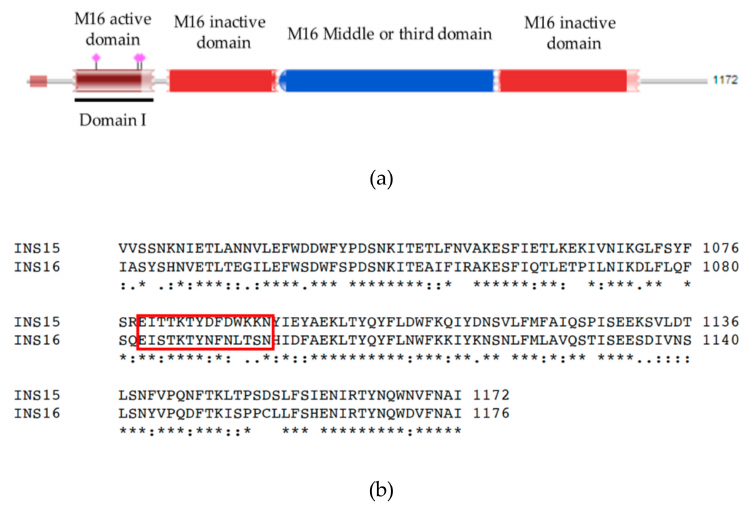
Figure 1. Sequence features of INS-15. ( a ) Diagram of INS-15 of Cryptosporidium parvum illustrating the presence of one M16 active domain, two inactive domains, and one middle or third domain. The black line identifies the domain I. ( b ) Alignment of partial amino acid sequences of INS-15 and INS-16 from C. parvum . The red box shows the di ff erences in amino acid sequences between NS-15 and INS-16 in the area of INS-15-specific polypeptide used in the study. Microorganisms 2019 , 7 , x FOR PEER REVIEW